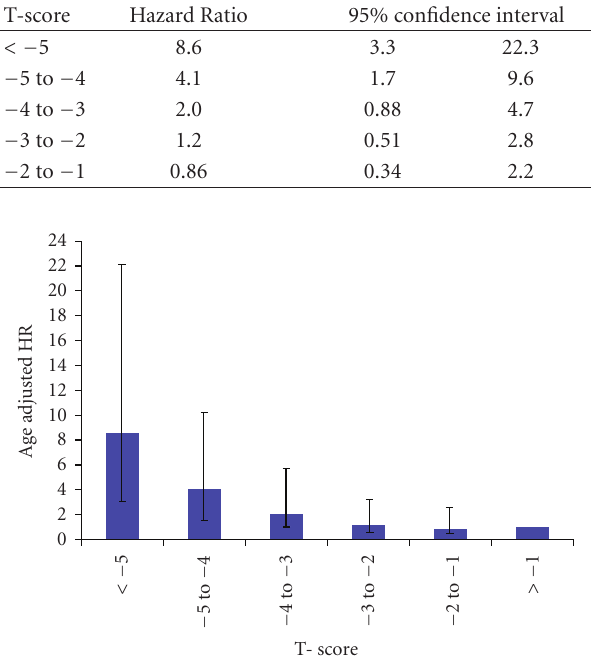
Figure 2: The age-adjusted hazard ratio with di ff erent T-score categories compared against the hip fracture rate at T-score > − 1.